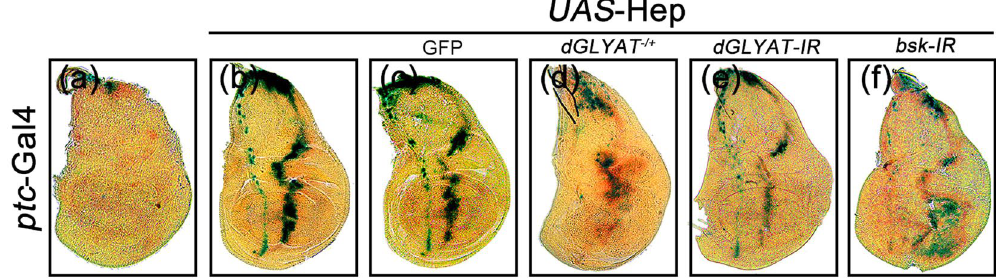
Figure 6. Loss of dGLYAT suppresses ectopic Hep-induced puc transcription in wing discs. Light micrographs of Drosophila third instar wing discs with X-Gal staining are shown. Compared with the ptc -Gal4 control ( a ), ptc > Hep-induced puc -LacZ expression in wing disc ( b ) is suppressed by mutation ( d ) or RNAi-mediated depletion of dGLYAT ( e ). Expression of GFP ( c ) and Bsk-IR ( f ) acts as a negative and a positive control (a, n = 8; b, n = 10; c, n = 5; d, n = 10; e, n = 11; f, n = 9).